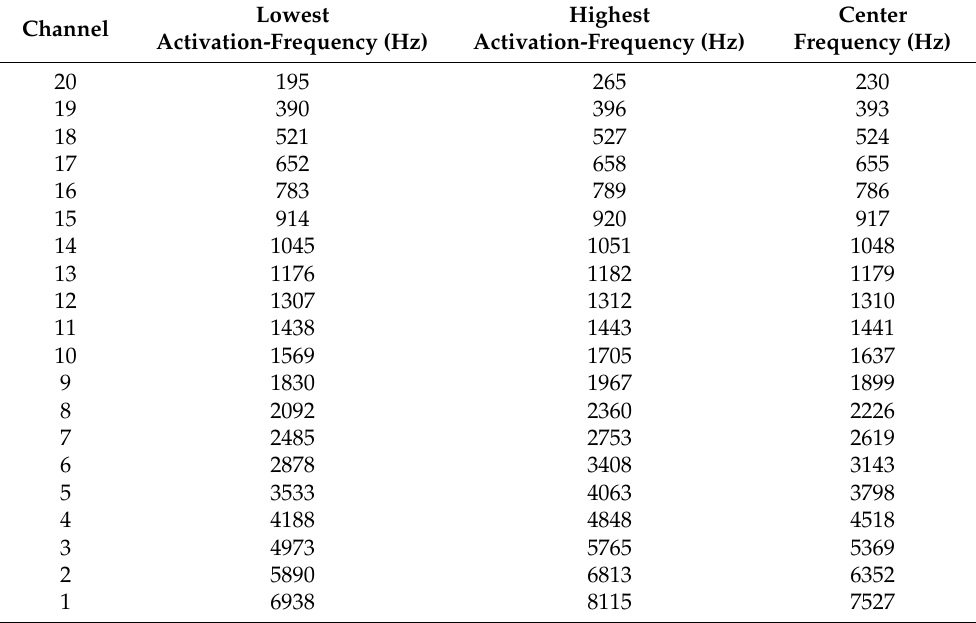
Table 2. Frequencies for single electrode activation.